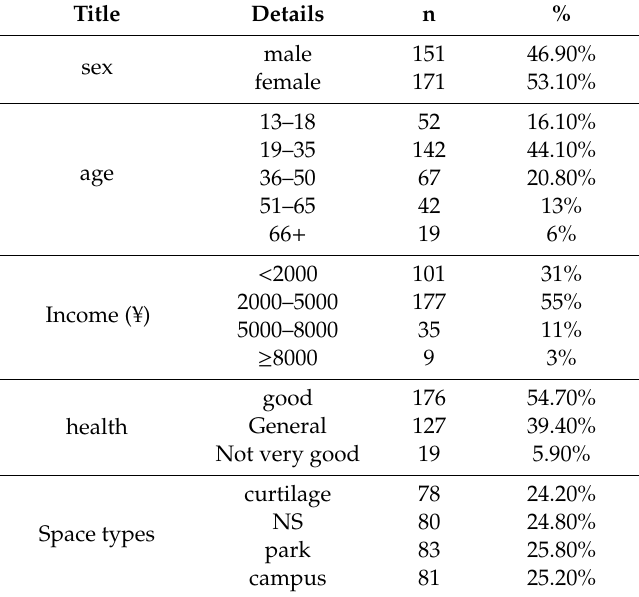
Table A1. Characteristics of participants.